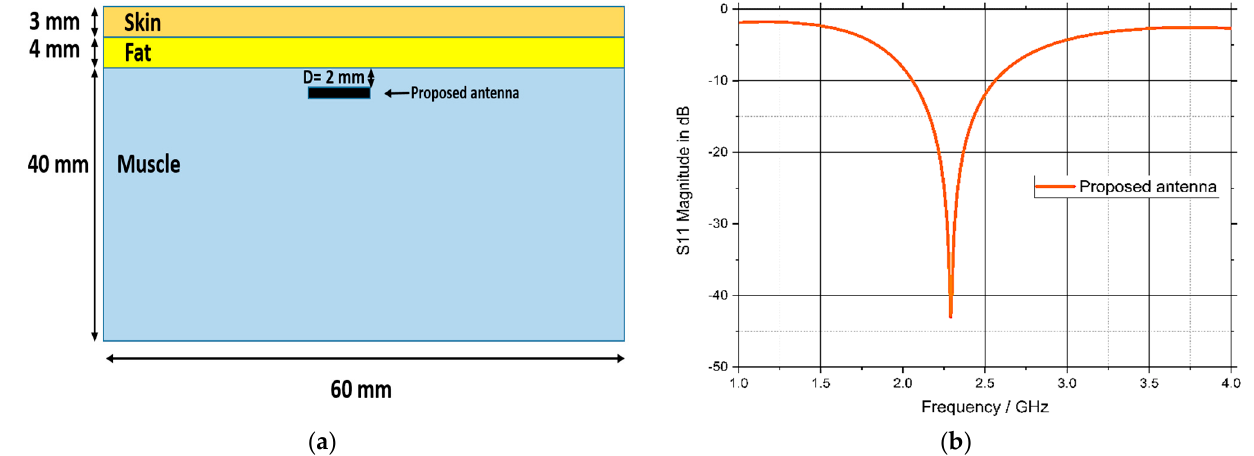
Figure 5. ( a ) Biological human body tissue model in CST Microwave Studio; ( b ) Reflection coefficient of the proposed WUCIA.